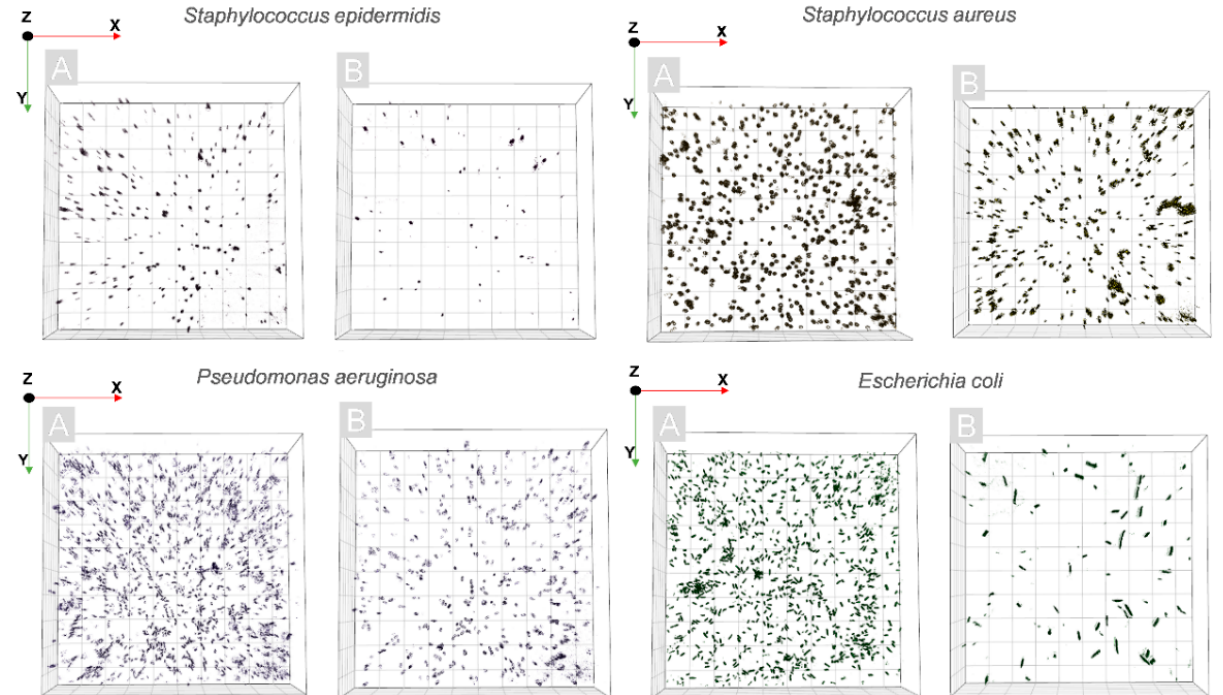
Figure 9. Representative digitally stained (based on the RI values) cells of S. epidermidis, S. aureus, P. aeruginosa, E. coli on the surface of the Ph-doped silica coating before ( A ) and 24 h after photoexcitation ( B ).